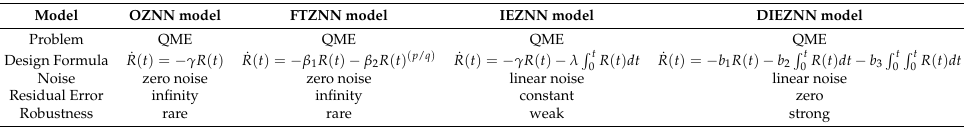
Table 1. Comparison of OZNN model, FTZNN model, IEZNN model and DIEZNN